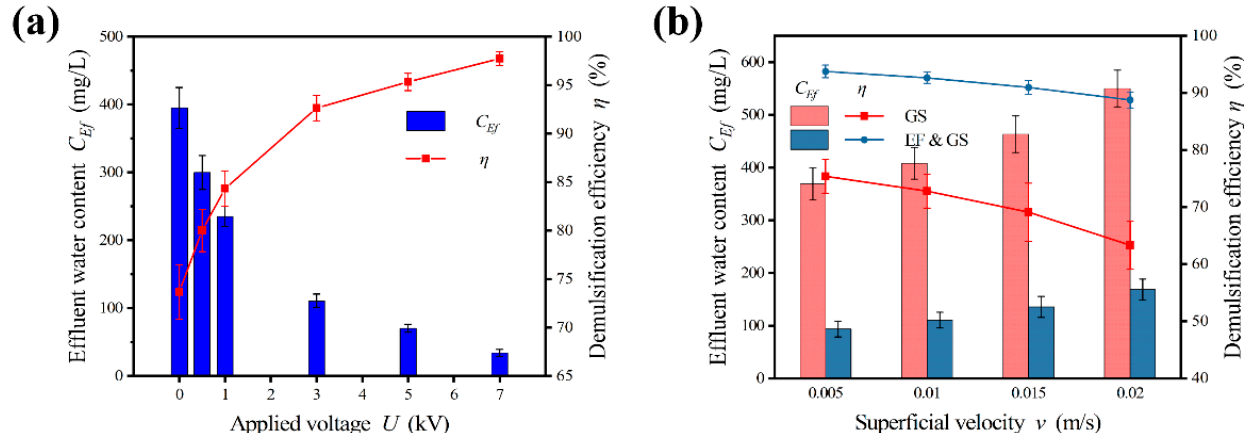
Figure 7. Effects of operating condition parameters. ( a ) Effect of applied voltage. ( b ) Effects of superficial velocity. Conditions: C in = 1500 mg/L; v = 0.001 m/s; U = 0–7 kV; GS medium bed with size of 1.0–2.0 mm and L* = 20cm.